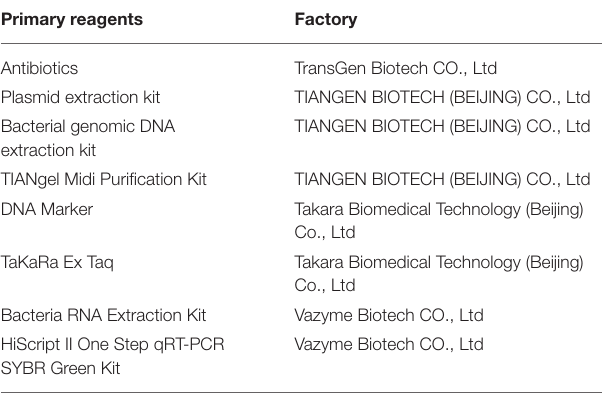
TABLE 1 | Main experimental reagents and